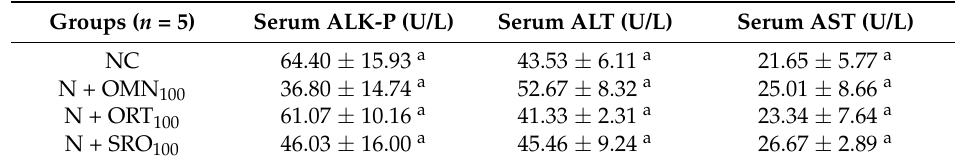
Table 1. Effect of Musa acuminata peels on some Serum Liver Marker Enzymes concentration in rats. Groups ( n =